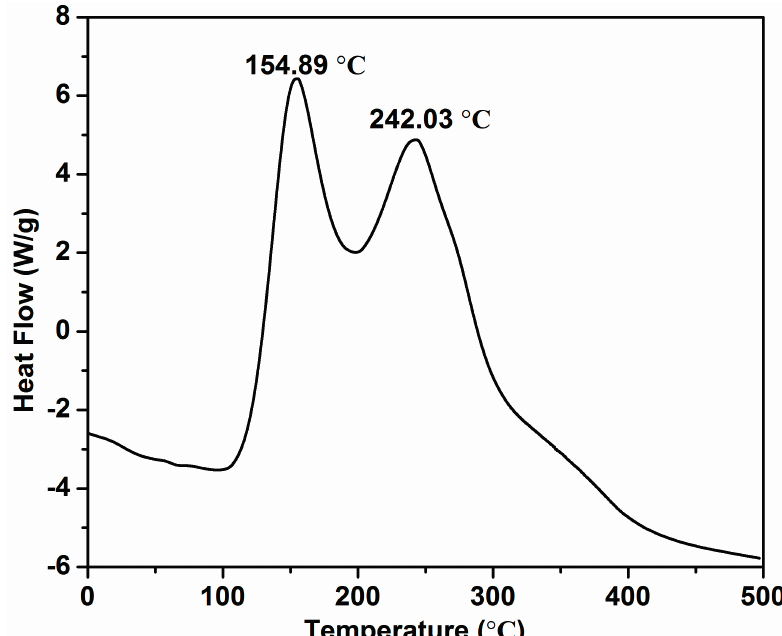
Figure 5. Differential scanning calorimetry (DSC) curve of C 60 -GAP under N 2